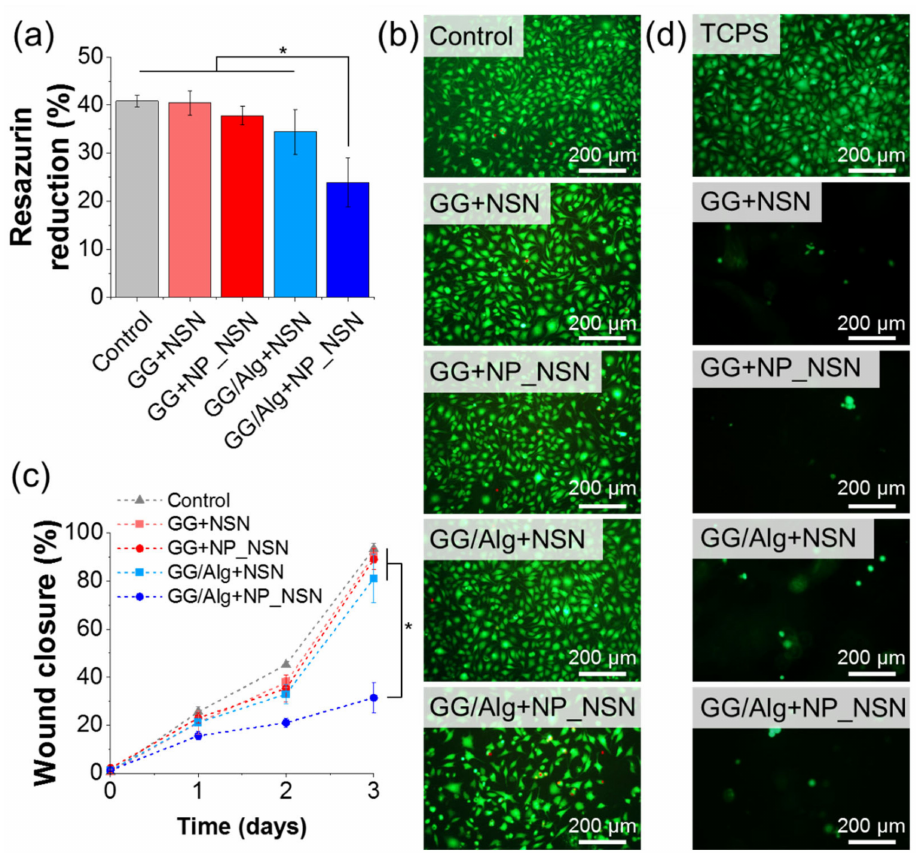
Figure 6. Cytocompatibility of GG and GG/Alg hydrogels containing NSN or NP + NSN: metabolic activity ( a ) and live/dead staining ( b ) of L929 cells incubated for 24 h in presence of sample extracts, wound healing assay performed for up to 3 days in presence of sample extracts ( c ) and evaluation of cell adhesion to the samples 24 h after cell seeding ( d ). Statistically significant differences at * p <